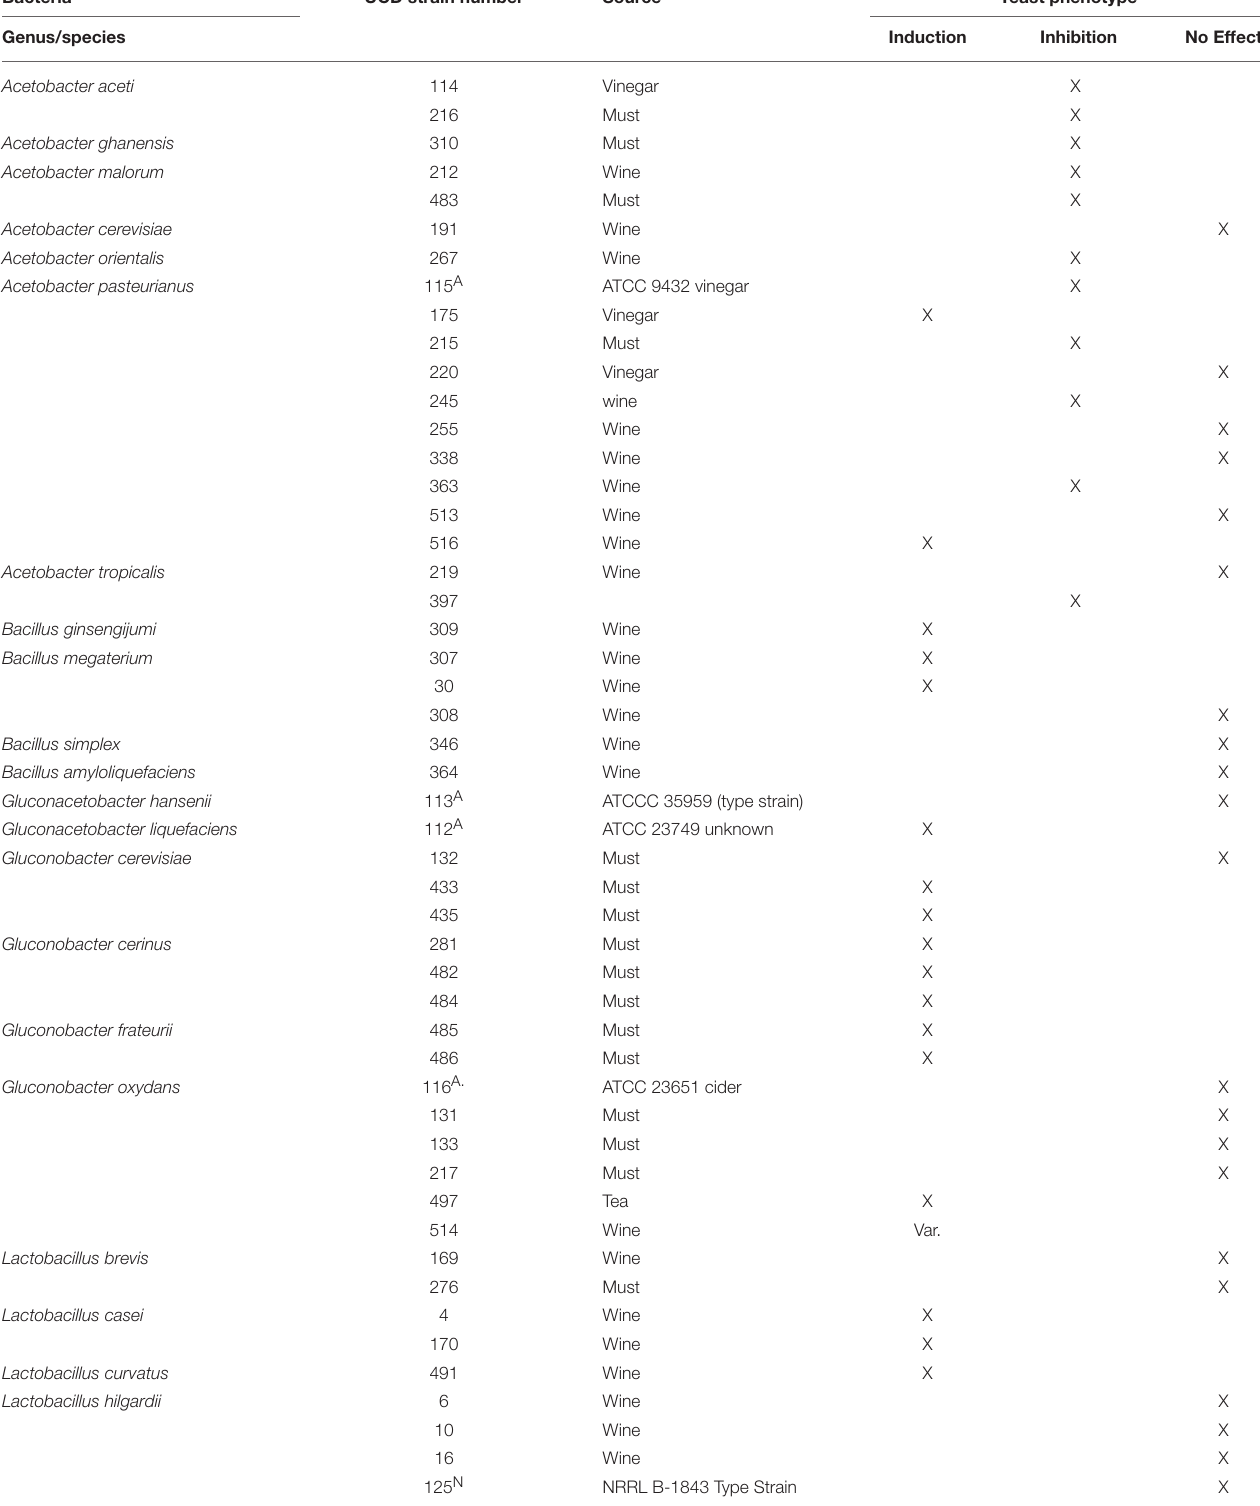
TABLE 1 | Impact of bacteria on [ GAR + ] prion induction and yeast growth